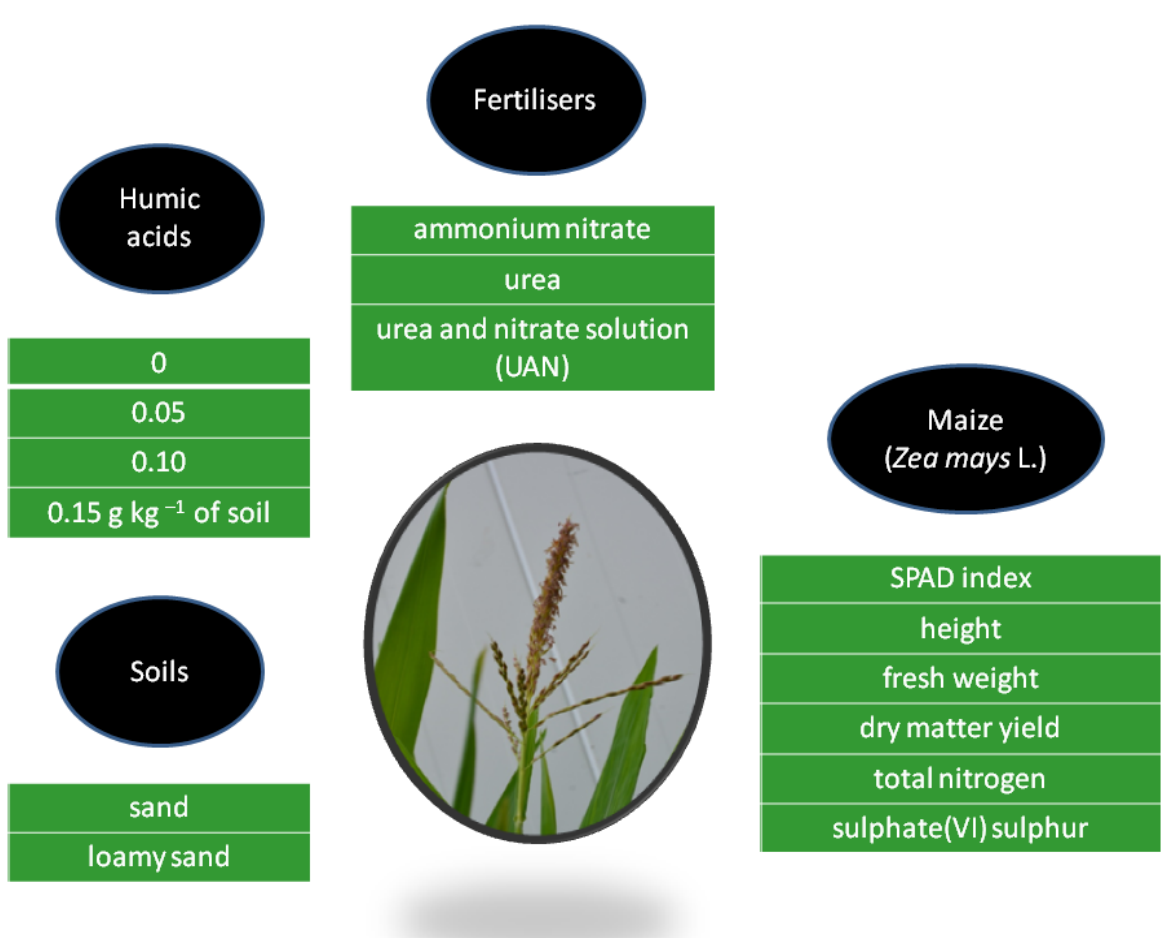
Figure 1. Experiment scheme.